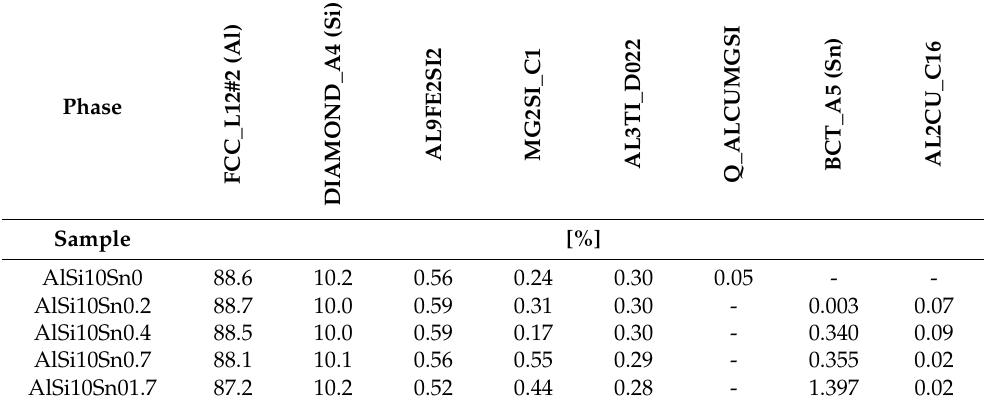
Figure 5. Graphical presentation of the share of selected phases that were obtained from TC model- ling at ambient temperature (20 °C); FCC_L12 # 2 (Al) and DIAMOND_A4 (Si) phases not shown.